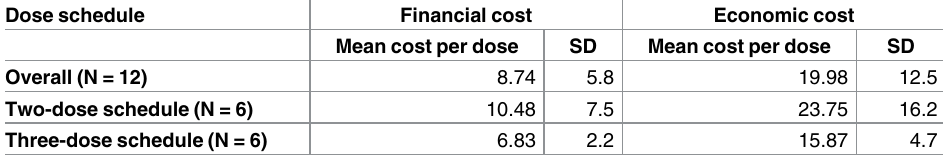
Table 4. HPV vaccine economic and financial costs of demonstration project countries, 2014 US$.